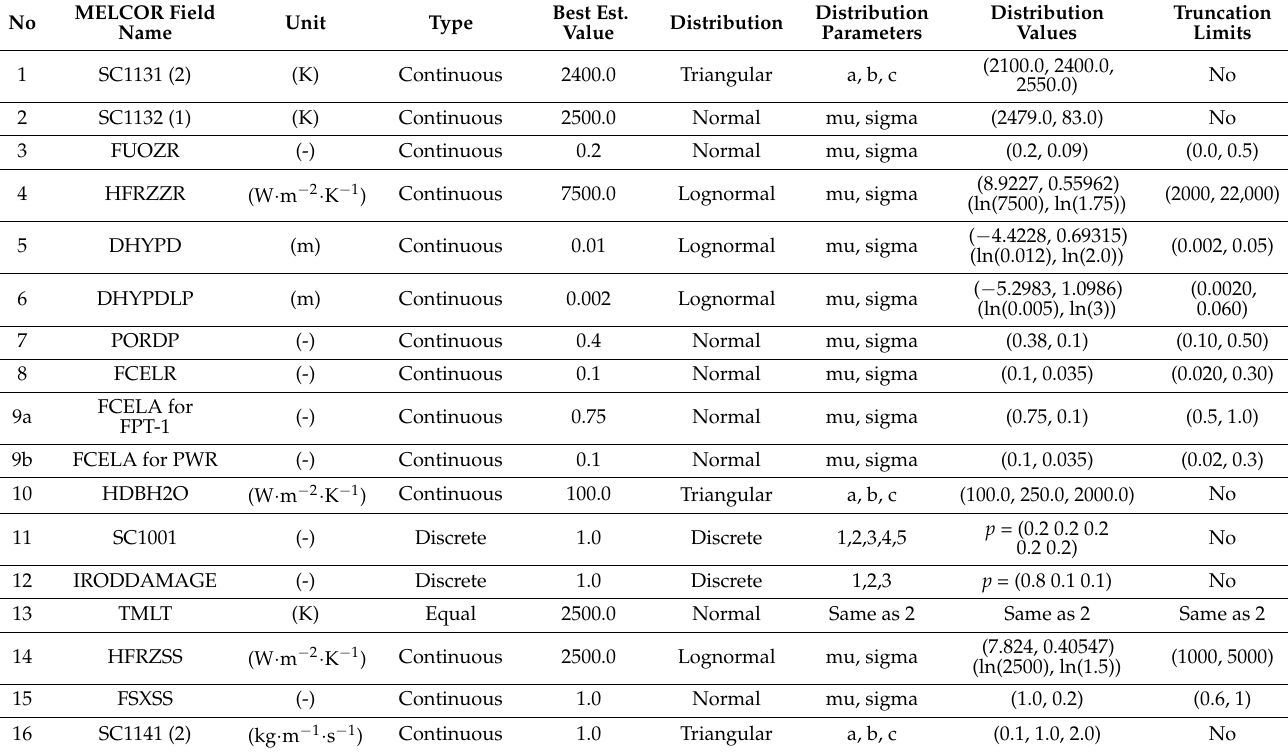
Table 2. Uncertainty parameters and distributions selected for the study.